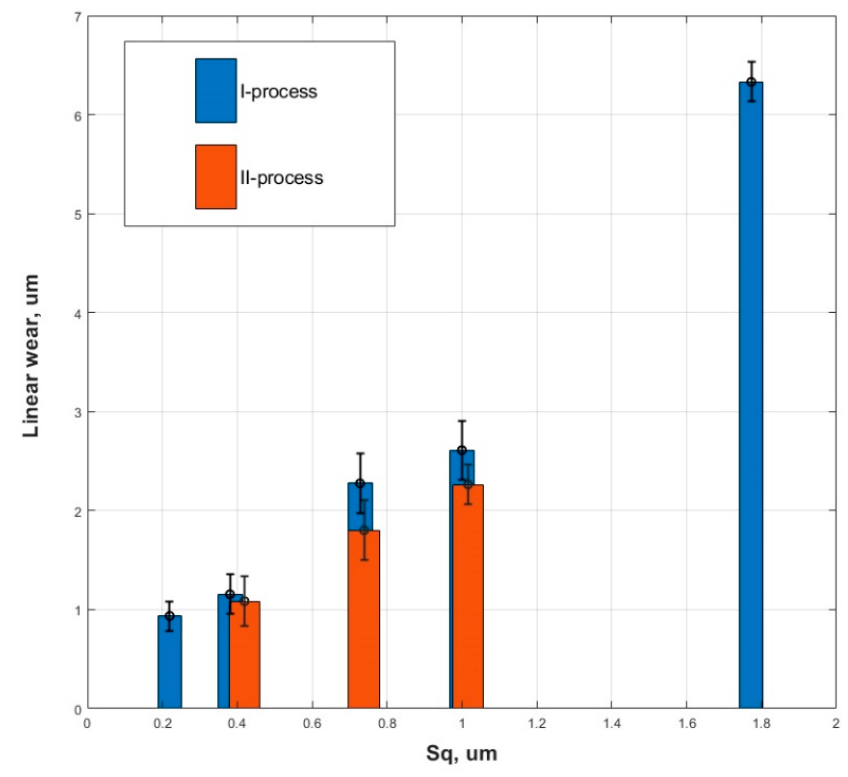
Figure 22. Dependence between the Sq parameter and the wear of the cylinder liner, adapted from